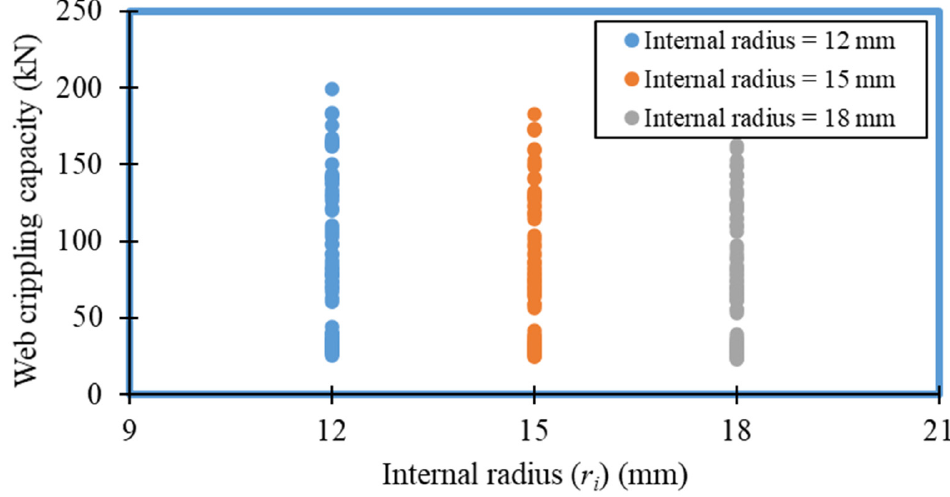
Figure 18. Effect of internal radius ( r i ) on the web crippling strength.